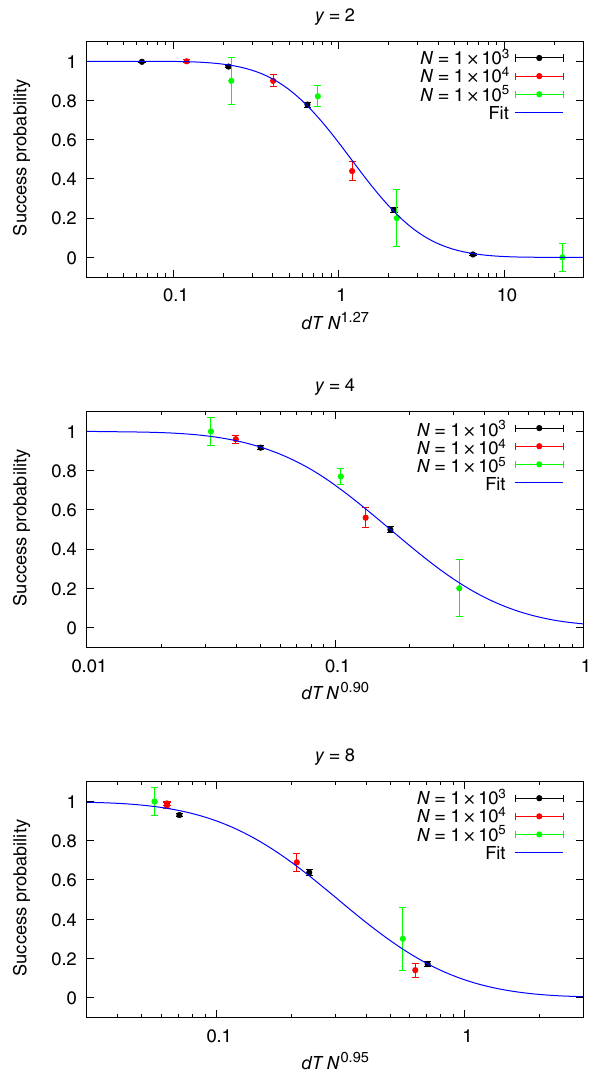
FIG. 10. The success probability of finding the planted state by running RSA on c ¼ 17 planted-coloring problems of size N with a constant annealing rate dT is a function of dTN a with a scaling exponent a close to 1 (at least for R ¼ 4 , 8). This implies the running times of RSA are roughly quadratic in N . The fit function is f ð x Þ ¼ erfc ½ð x − x 0 Þ =b (cid:3) .